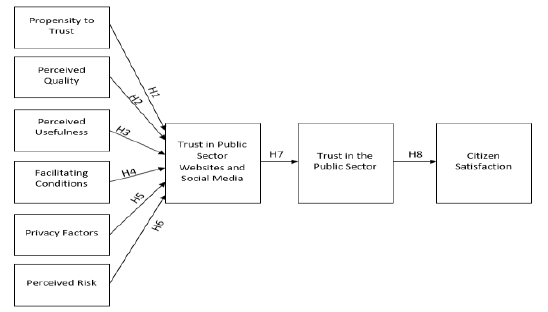
Figure 1. Proposed Research Model